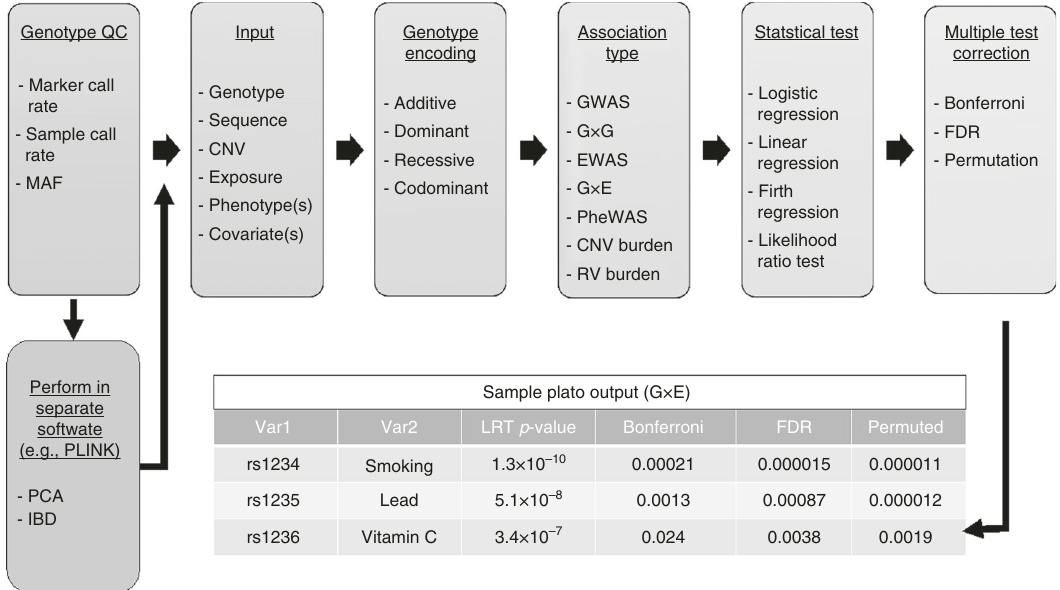
Fig. 1 PLATO pipeline. This fl ow chart depicts a typical research pipeline using PLATO. Call rates and minor allele frequency (MAF) can be executed in PLATO and other options for QC are performed elsewhere. A variety of data types can be used as inputs to PLATO, including PLINK fi les (genotype data), VCF fi les (sequence data), copy number variant (CNV) data, and exposure data, as well as one or more phenotypes and covariates for adjustment. PLATO